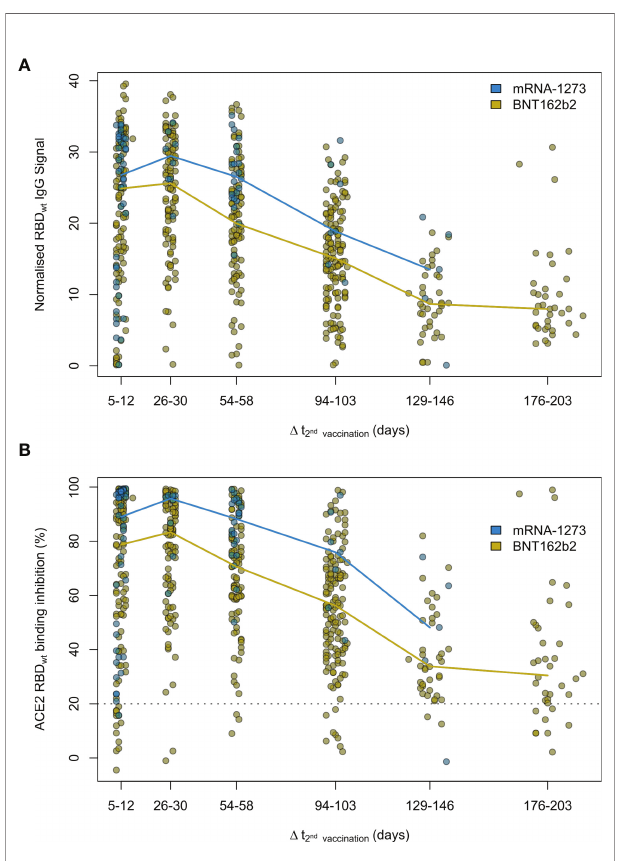
FIGURE 6 | Antibody and neutralization response kinetic up to 7 months after SARS-CoV-2 mRNA vaccination. Humoral vaccine response was assessed by MULTICOV-AB (A) and an ACE2-RBD competition assay (B) using the time point sample set. Samples were either 5 to 12, 26 to 30, 54 to 58, 94 to 103, 129 to 146 and 176 to 203 days post-second dose of either a two-dose BNT162b2 (yellow, n = 515) or mRNA-1273 (blue, n = 82) vaccination. Colored line connects median response per time point and vaccine. Data is displayed as normalised IgG RBD ratio or as % ACE2 binding inhibition where 100% indicates maximum binding inhibition and 0% no binding inhibition. The threshold for non- responsive samples (ACE2 binding inhibition less than 20%) is shown as dotted line. All samples below this threshold can be considered non-responsive. Median values with 95% CI and IQR of RBD wt IgG signal and ACE2 binding inhibition are shown in Supplementary Table 7